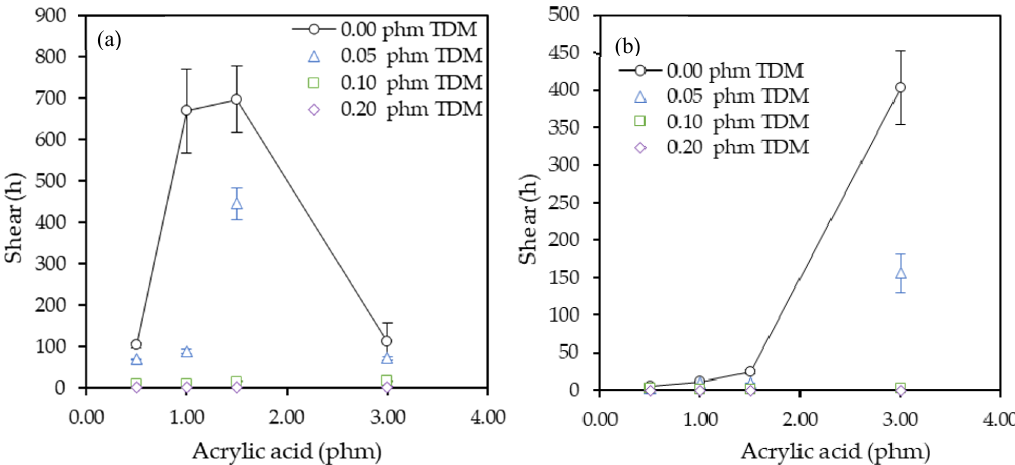
Figure 7. Effect of the acrylic acid and tert-dodecyl mercaptan (TDM) in the static shear test on steel panels for ( a ) PET and ( b ) paper tapes.